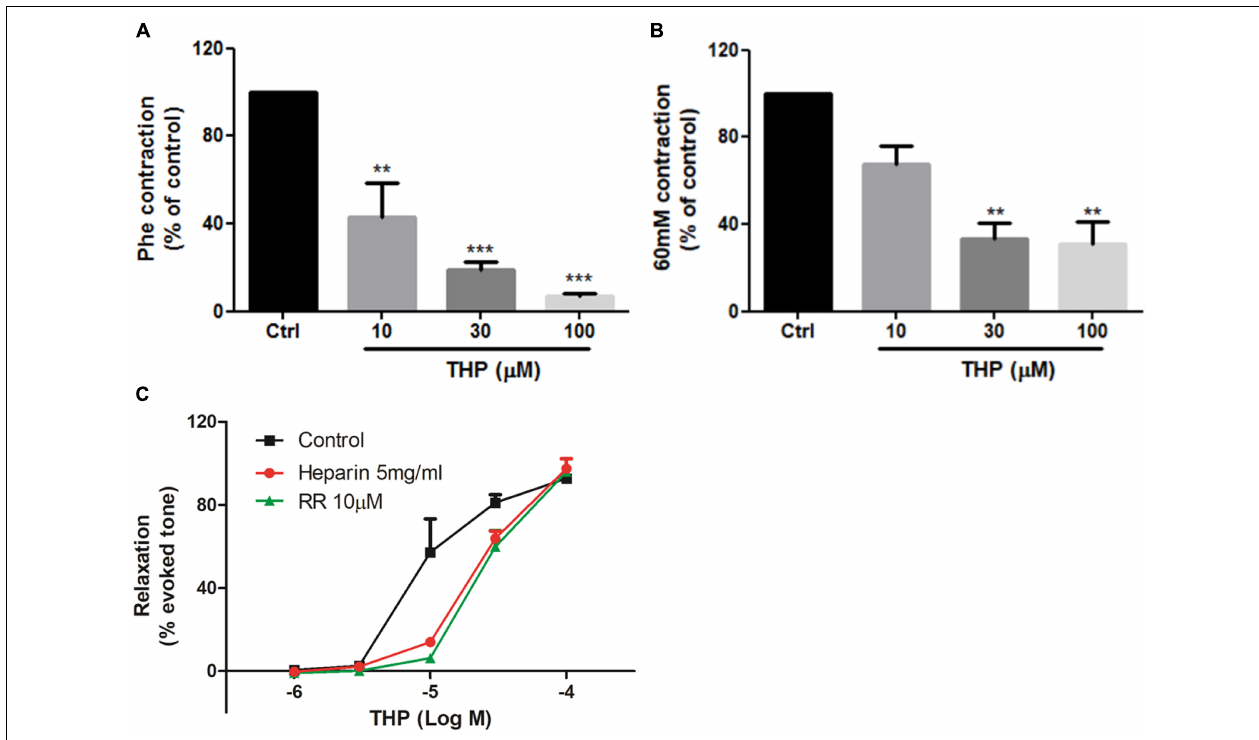
FIGURE 4 | Tetrahydropalmatine inhibited intracellular Ca 2 + release-induced vascular contraction. (A) Pre-treatment THP (10, 30, and 100 µ M) suppressed KCl (60 mM) induced contraction of aorta in Ca 2 + -free Krebs solution. (B) Pre-treatment THP (10, 30, and 100 µ M) suppressed Phe (1 µ M) induced vascular contraction of aorta in Ca 2 + -free Krebs solution. (C) Pre-incubation Ryr inhibitor ruthenium red (RR, 10 µ M) or IP3 receptor inhibitor heparin (5 mg/ml) attenuated THP induced rat aorta relaxation in Phe (1 µ M) induced vascular tension in Ca 2 + -free Krebs solution. Vascular contraction and relaxation presented as percentage of control or evoked tone. Results were means ± SEM of more than three experiments. ∗∗ P < 0.01, ∗∗∗ P < 0.001 versus control